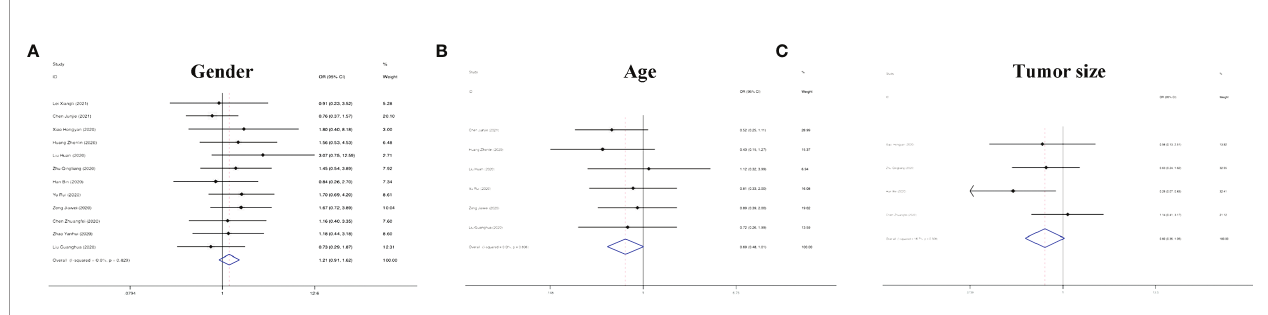
Supplementary Figure 1 | Sensitivity analysis (A, D) and Publication bias judged by Egger ’ s (B, E) and Begg ’ s (C, F) funnel plots of circRNAs for the OS and PFS/ CCS/MFS/DFS in RC. Supplementary Figure 2 | Sensitivity analysis of the circRNAs for (A) Fuhrman grade, (B) T stage, (C) lymphatic metastasis, (D) M stage, (E) TNM stage, (F) gender, (G) age, and (H) tumor size in RC. Supplementary Figure 3 | Publication bias judged by Egger ’ s funnel plots of the circRNAs for (A) Fuhrman grade, (B) T stage, (C) lymphatic metastasis, (D) M stage, (E) TNM stage, (F) gender, (G) age, and (H) tumor size in RC. Supplementary Figure 4 | Publication bias judged by Begg ’ s funnel plots of the circRNAs for (A) Fuhrman grade, (B) T stage, (C) lymphatic metastasis, (D) M stage, (E) TNM stage, (F) gender, (G) age, and (H) tumor size in